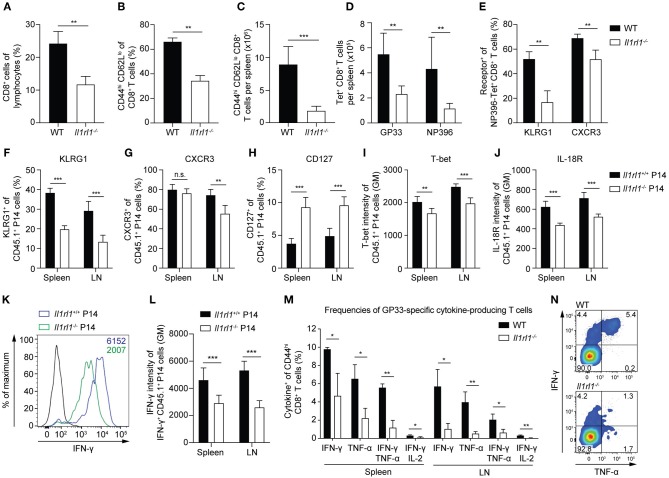
IL-33 enhances CD8+ T cell activation and differentiation during a primary viral infection. (A–E) WT and Il1rl1−/− mice were infected with a low dose (LD, 200 PFU) LCMV-WE and spleens were analyzed at day 6.5 after infection (n = 5). (A) Frequency of CD8+ T cells among lymphocytes. Frequency (B) and absolute numbers (C) of splenic CD44hi CD62Llo effector CD8+ T cells. Total count of GP33-and NP396-tetramer+ CD8+ T cells per spleen (D) and frequency of KLRG1+ and CXCR3+ cells among NP396-tetramer+ CD8+ T cells (E). (F–L) Naive Il1rl1+/+ and Il1rl1−/− P14 cells were transferred into WT recipients. Recipients were subsequently infected with a low dose (LD, 200 PFU) LCMV-WE. P14 cells from spleen and lymph nodes were analyzed at day 6.5 after infection (n = 5–6). Frequencies of KLRG1+
(F), CXCR3+
(G), and CD127+
(H) cells among CD45.1+ P14 cells. Expression levels of T-bet (I) and IL-18R (J) of CD45.1+ P14 T cells plotted as geometric mean (GM) of fluorescence intensity. Representative histogram (K) and quantification (L) of IFN-γ production by Il1rl1+/+ and Il1rl1−/− P14 cells after restimulation with GP33 peptide (black histogram: unstimulated Il1rl1+/+ P14 cells). (M,N) WT and Il1rl1−/− mice were infected with a low dose (LD, 200 PFU) LCMV-WE. Spleen and lymph nodes were analyzed after GP33 peptide restimulation at day 6.5 post infection. (M) Frequencies of cytokine-producing GP33-specific CD44hi CD8+ T cells and a representative FACS plot of IFN-γ and TNF-α expression (N) by CD44hi CD8+ T cells. Bars indicate the mean + SD (n = 3). P-values were calculated with unpaired two-tailed Student's t-test. *P < 0.05, **P < 0.01, and ***P < 0.001.